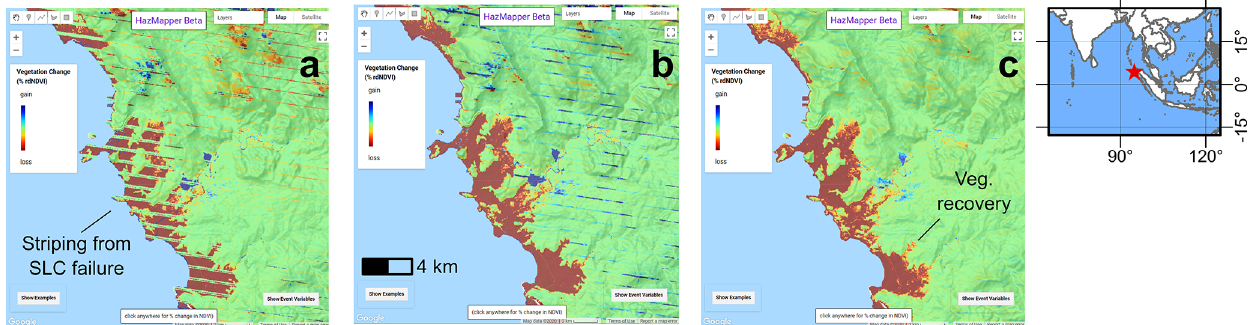
Figure 8. rdNDVI change detection images illustrate coastal erosion, vegetation removal, and sedimentation following the 26 December 2004 tsunami in Indonesia resulting from the Sumatra–Andaman earthquake. Parameters – dataset: Landsat 7; event date: 26 December 2004; maximum cloud cover: 100%; slope threshold: 0.01 ◦ . Pre-windows: 1, 2, and 12 months; post-windows: 1, 2, and 12 months for (a) , (b) , and (c) , respectively. rdNDVI across the event illustrates tsunami inundation zone and resulting loss in vegetation. Striping in the data from the scan line corrector failure in Landsat 7 is evident in a short-look window (e.g., 1 month, a ), but these artifacts are reduced by increasing the pre- and post-event windows (b, c) . By 12-month pre- and post-event periods (c) , the striping is significantly reduced in results; however, vegetative recovery is also present in this longer post-event cycle that captures the first growing season following the tsunami. This example is accessible at https://go.ncsu.edu/hazmapper-indonesia-tsunami (last access: 29 April